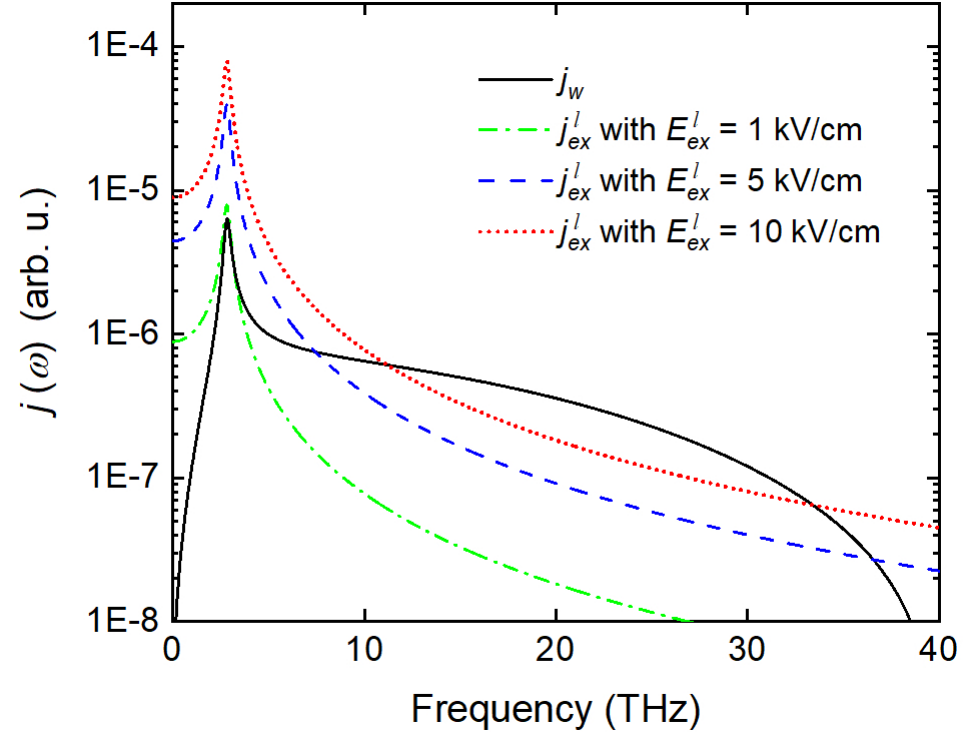
Figure 6: The wake current spectrum (black line) and the additional spectral currents with longitudinal external electric fields of 1 kV / cm (green dot and dash line), 5 kV / cm (blue dashed line) and 10 kV / cm (red dotted line),